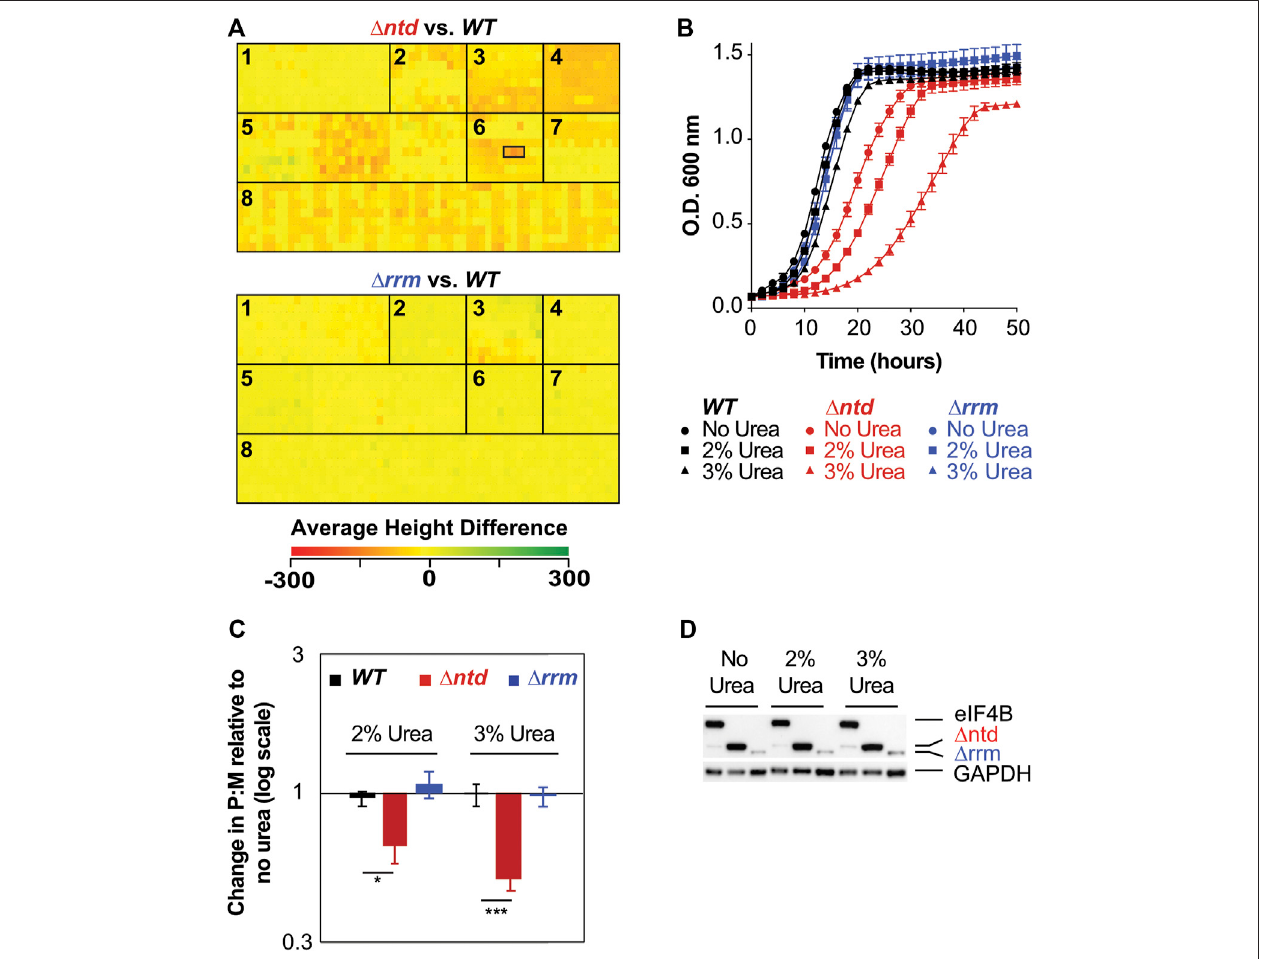
FIGURE 2 | eIF4B binding to the 40S promotes resistance to stressors that challenge cellular integrity through changes in translation. (A) Heatmap of average height differences for cellular fi tness between the NTD (top) or RRM (bottom) deletion mutant (green) and WT (red) under 1440 metabolic and chemical conditions as assayed by Phenotype microarray, which includes seven panels in 15 96-well plates: 1. Carbon Sources; 2. Nitrogen Sources; 3. Phosphorus and Sulfur Sources; 4. Nutrient Supplements; 5. Peptide Nitrogen Sources; 6. Osmolytes; 7. pH; and 8. Chemical Sensitivity. Wells containing 2, 3, and 4% urea are outlined by a black box,lefttoright,for Δ ntd.3%UreagavethelargestdifferenceinWTand Δ ntd fi tness.Therewerenoconditionsthatgaveasigni fi cantchangefor Δ rrm (B) .Growthcurves of WT (black), Δ ntd (red), and Δ rrm (blue) grown with 0% (circles), 2% (squares), or 3% urea (triangles). Results from biological triplicates ± SEM are shown. (C) Relative change in polysome to monosome (P:M) ratio upon exposure to urea was determined as in 1B with representative traces shown in Supplementary Figure S2 in